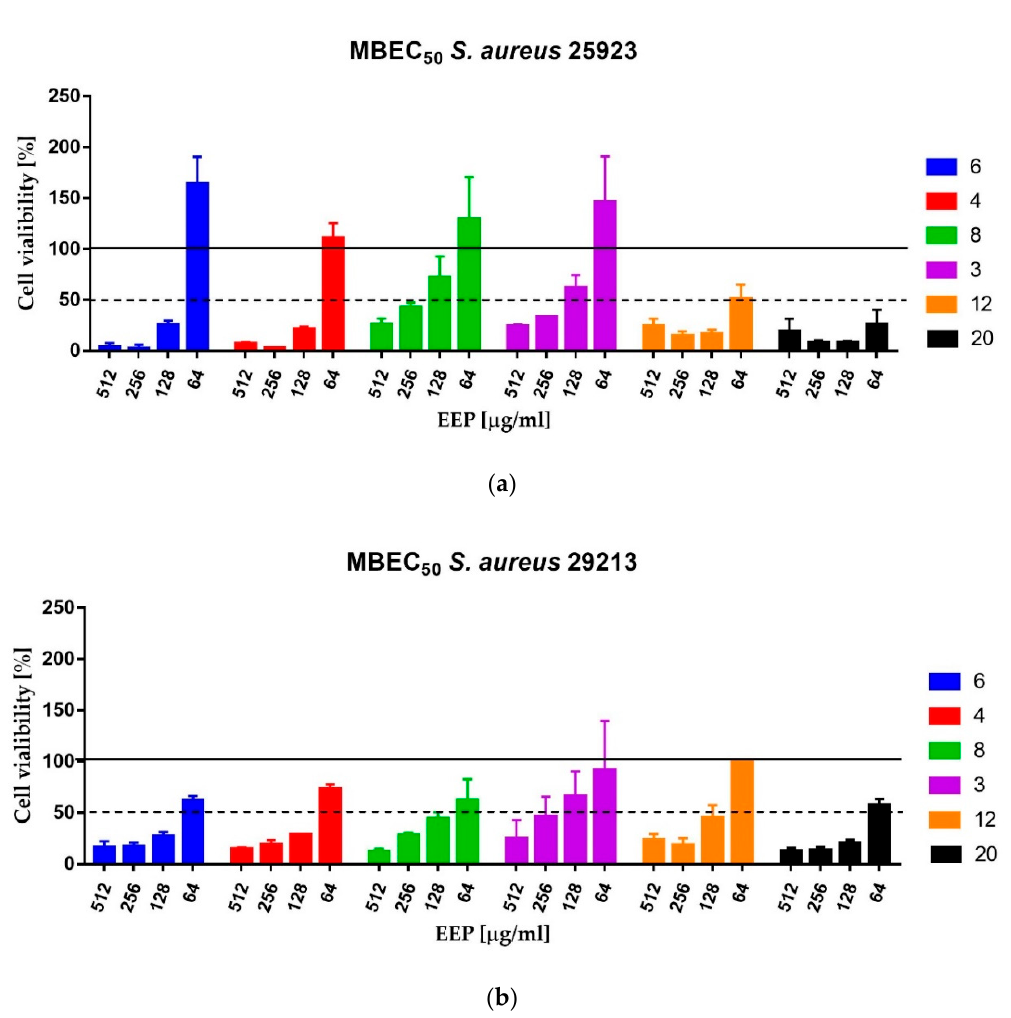
Figure 2. Anti-biofilm activity of selected EEPs against S. aureus ATCC 25923 ( A ) and S. aureus ATCC 29213 ( B ).